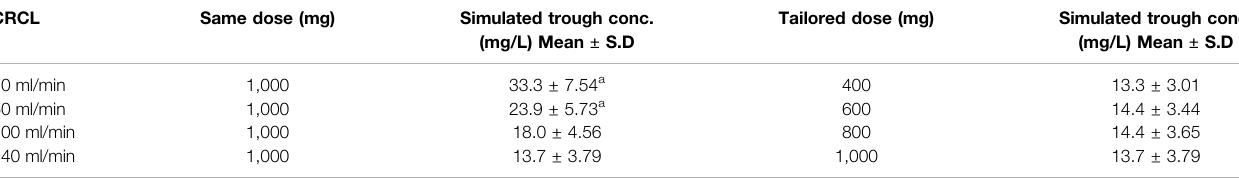
TABLE 3 | Trough concentrations for common and tailored doses simulated for patients with different levels of creatinine clearance. CRCL Same dose (mg) Simulated trough conc. (mg/L) Mean ±